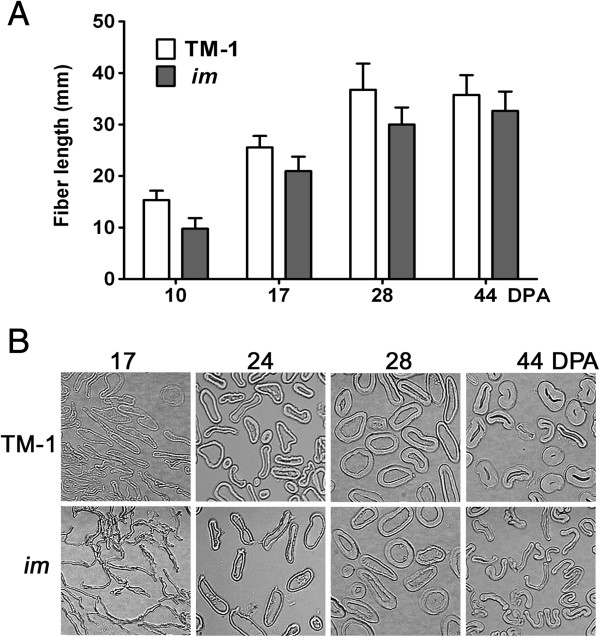
Comparisons of fiber properties from TM-1 wild type and im mutant. A. Fiber length comparison. The average fiber lengths of developing fibers at 10, 17, and 28 DPA were manually measured, and the average fiber length of mature fibers at 44 DPA was measured by AFIS. Average fiber lengths of developing fibers at each time point were calculated from two replicate samples with 30 ovules per replicate. The error bars represent SD. B. Microscopic image analyses. Cotton fibers at 17, 24, and 44 DPA from the TM-1 and im were cross-sectioned, embedded, and photographed.